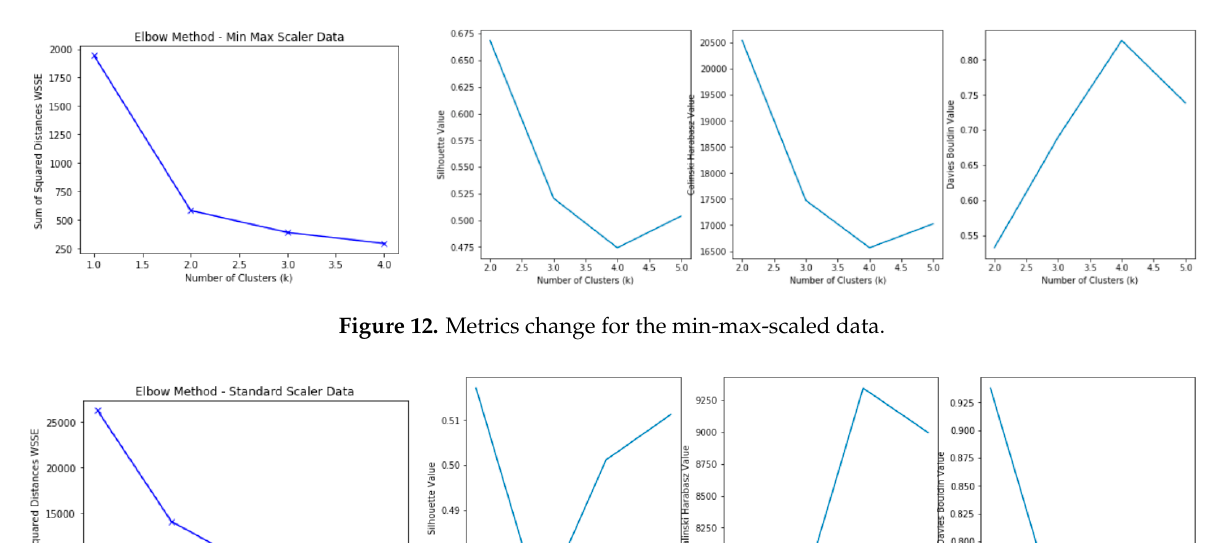
Figure 12. Metrics change for the min-max-scaled data .